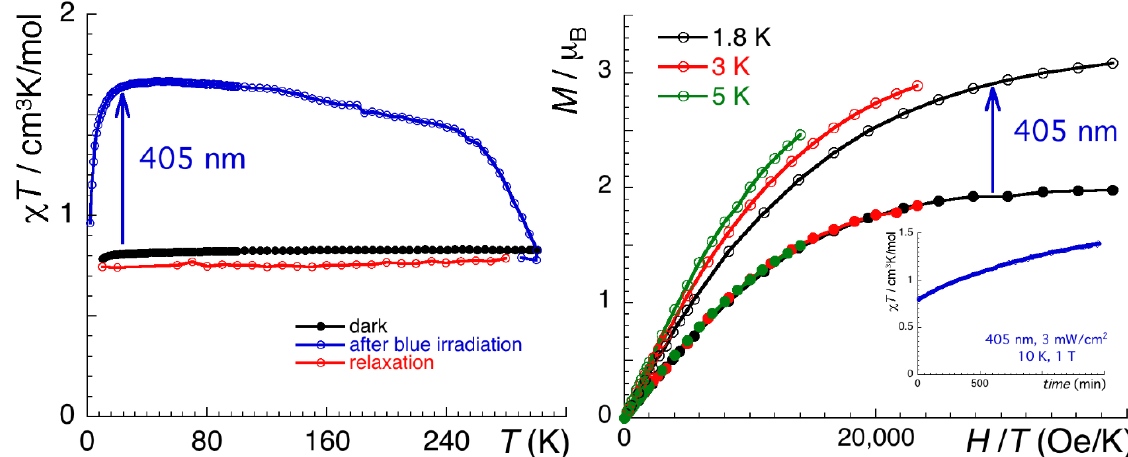
Figure 3. ( Left ) χ T = f( T ) plots of 1 measured at 1 T and 0.4 K/min: in the dark before irradiation (dark points), after 405 nm irradiation (open blue points) and after a reconditioning to 300 K (red points). ( Right ) Reduced magnetizations at different temperatures (1.8 K, 3 K and 5 K) before irradiation (full points) and in the photo-excited state of 1 (open points). (Insert: Time dependence of the χT for 1 measured at 1 T and 10 K, with continuous irradiation of wavelength at 405 nm (3 mW/cm 2 )).